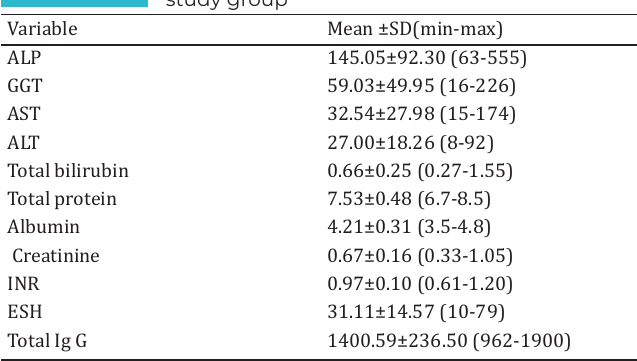
Evaluation of biochemical variables in the study group